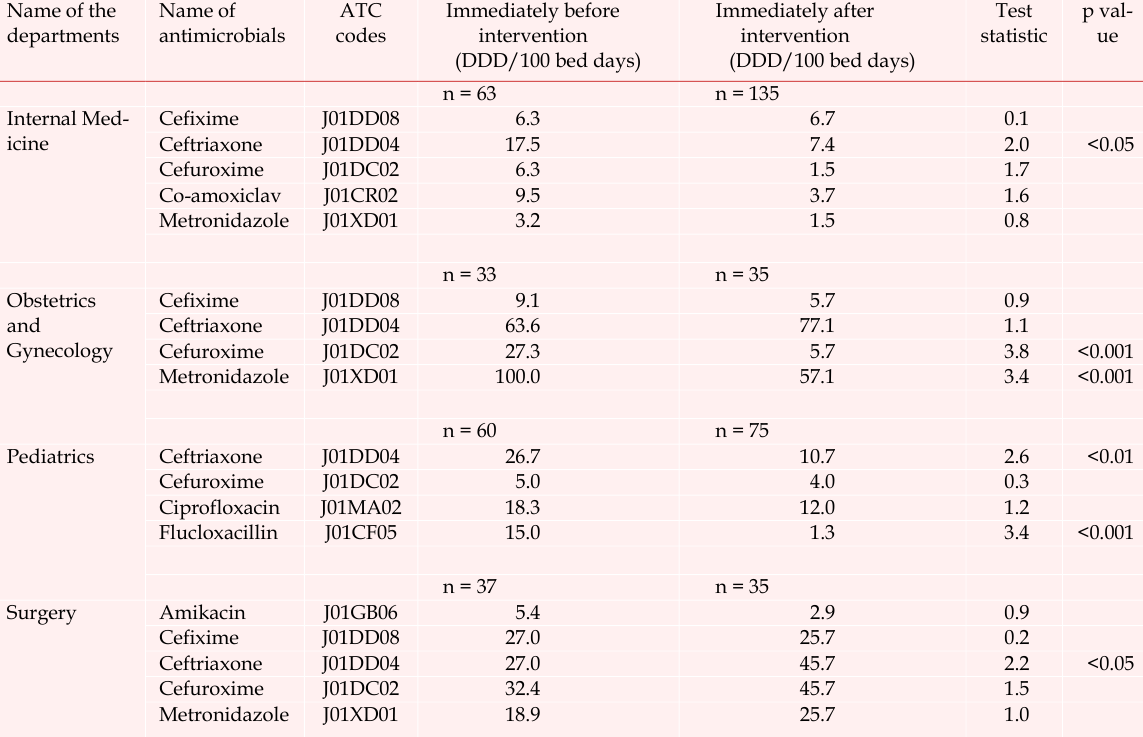
Effect of anti-microbial guideline with ASP on overall use of antimicrobials (expressed in DDD/100 bed days)